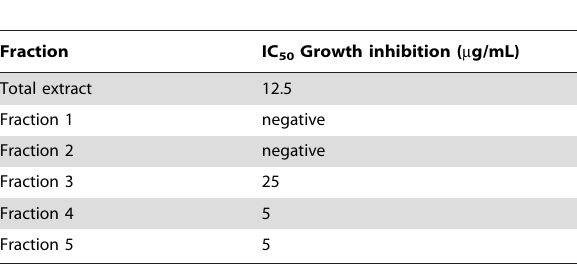
Table 1. Growth inhibition of E. coli strain BAS3023 by lichen Hypotrachyna sp . HP20ss fractions.